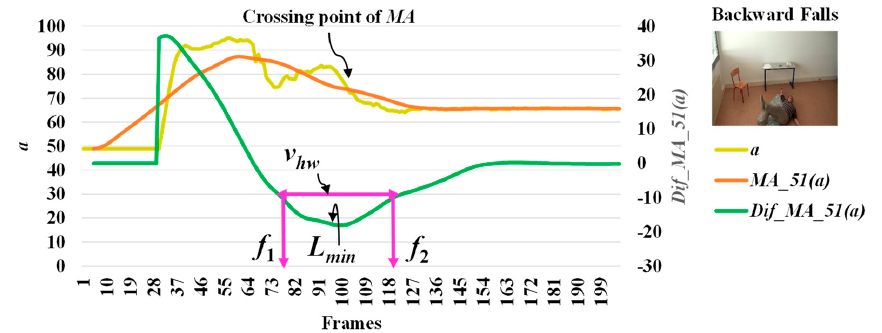
Figure 6. Analysis for a high possibility of abnormal (falling) points based on the area of the object shape ( a ) by falling backwards.